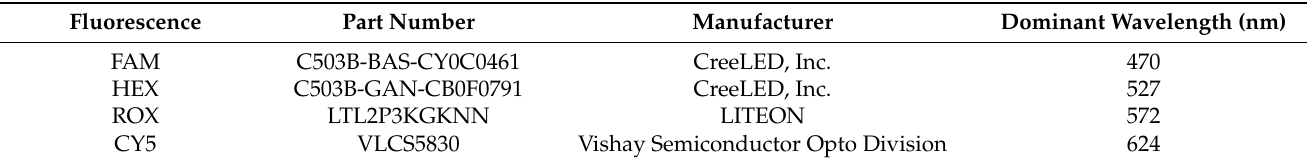
Table 2. The part number, manufacturer, and millicandela rating of the LED mounted on the excitation device. Fluorescence